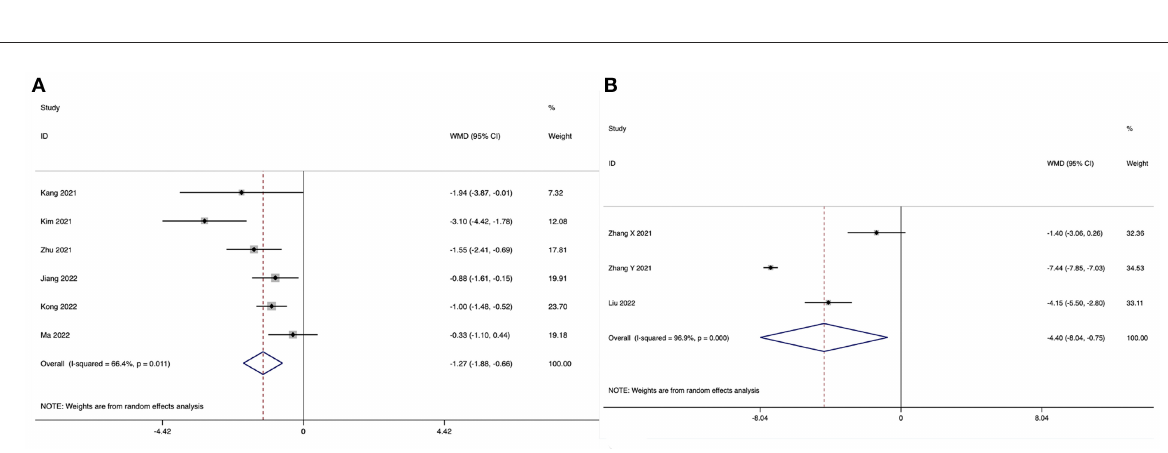
FIGURE4 Forest plot of the length of hospital stay. (A) ULIF vs. MI-TLIF; (B) ULIF vs. PLIF.